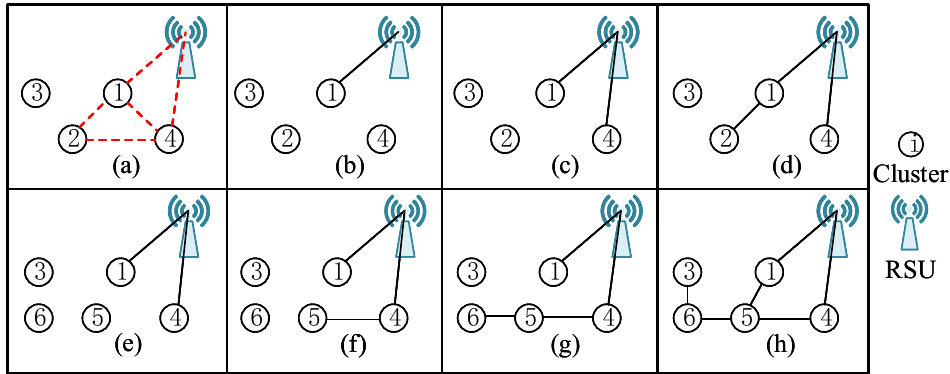
Figure 4. Example diagram of the running process of Algorithm 2. ( a ) The topology diagram between CH and RSU; ( b – h ) the running processes of Algorithm